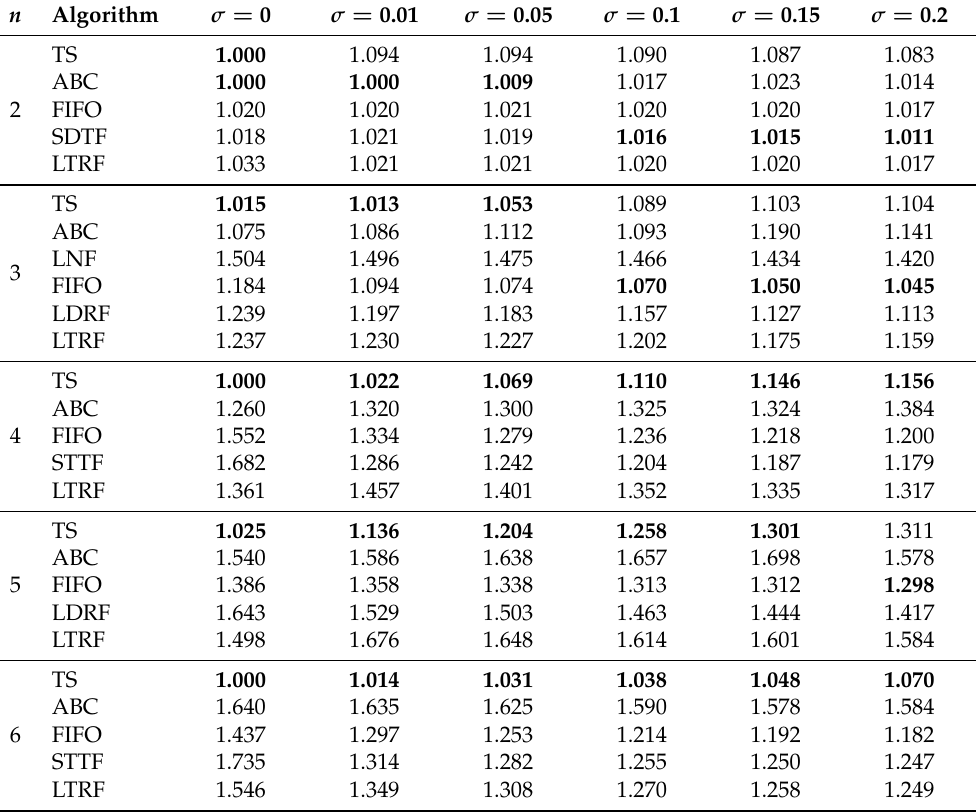
Table 4. Aggregated average PRD results for selected algorithms, grouped by number of robots (best result for each scenario type in